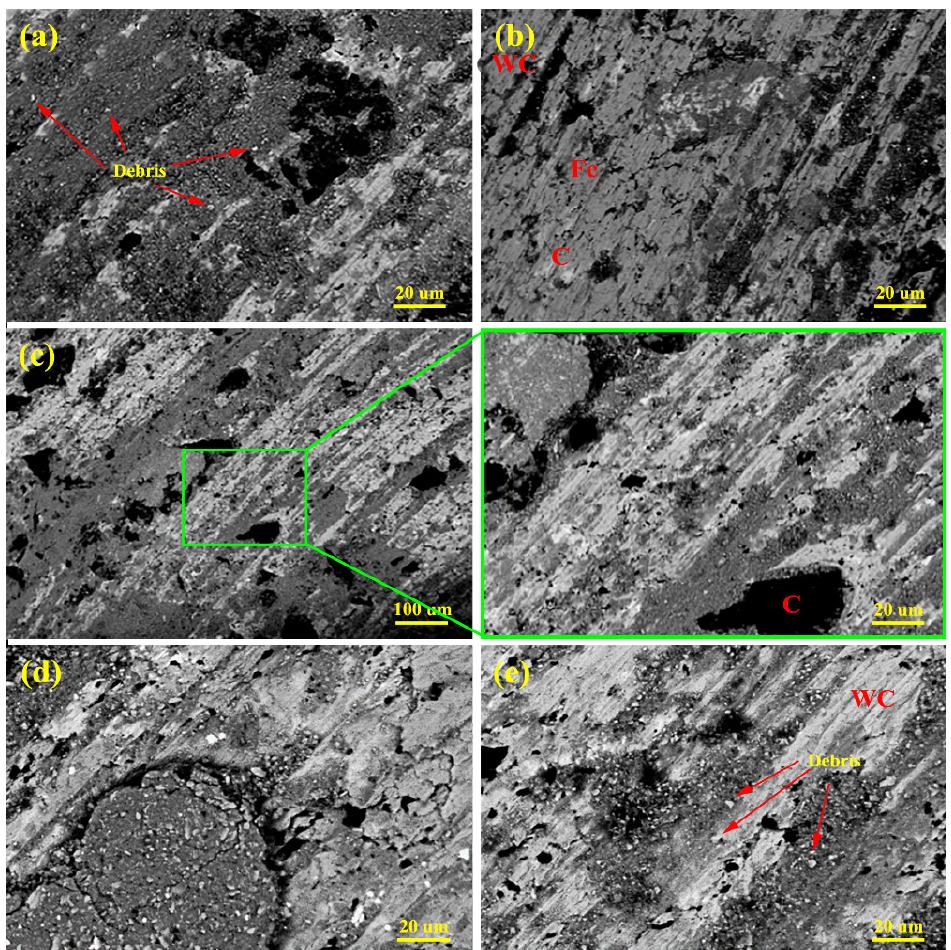
Figure 11. BSE image of worn surface of: ( a ) sample 1, ( b ) sample 2, ( c ) sample 3, ( d ) sample 5, and ( e ) sample 6.